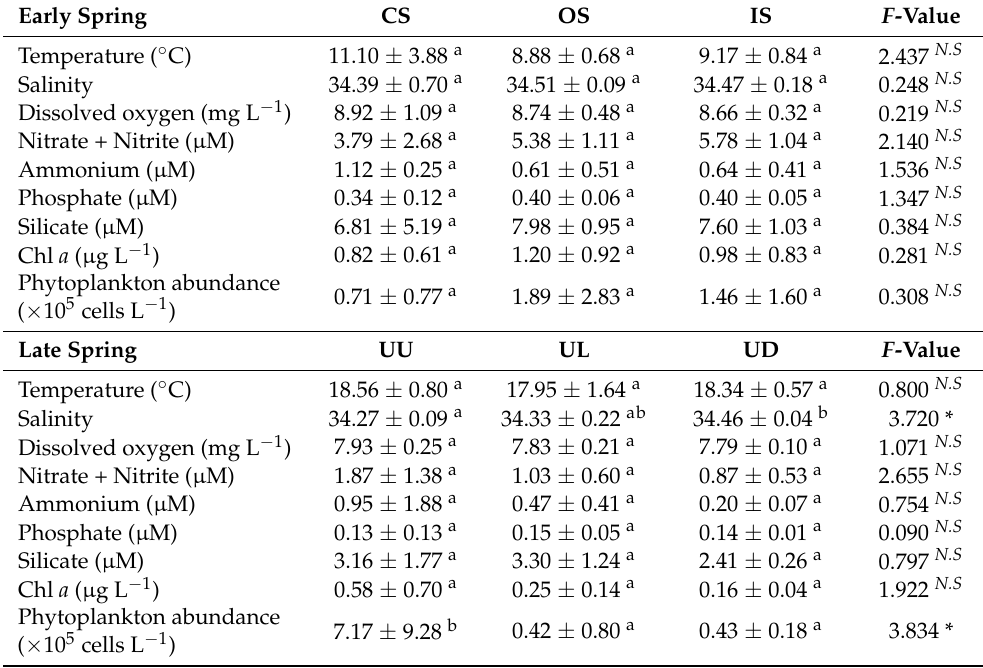
Figure 3. Horizontal distribution of temperature and salinity, obtained from a YSI sonde at all sampling stations during early spring ( a , 27 February to 5 March) and late spring ( b , 3 to 7 June) in the East Sea. Data after the dashed lines indicate resampled stations. Bars are color-coded by zone ( a, green: CS, light blue: OS, dark blue: IS; b, red: UU, orange: UL, yellow: UD). Table 1. Abiotic and biotic factors in three designated zones during early spring (27 February to 5 March) and late spring (2 to 7 June). The surface data were averaged for each zone. Values are means ± standard errors, and results were compared using one-way ANOVA with Tukey’s post hoc test. Means with the same letter are not significantly different ( N.S ). p > 0.05: N.S ; p < 0.05: